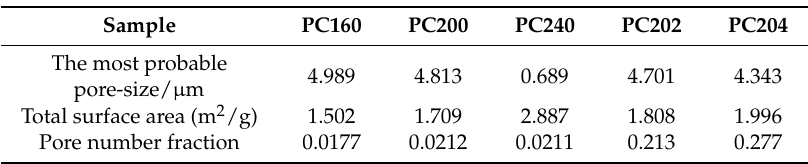
Table 1. Mercury intrusion porosimetry analysis